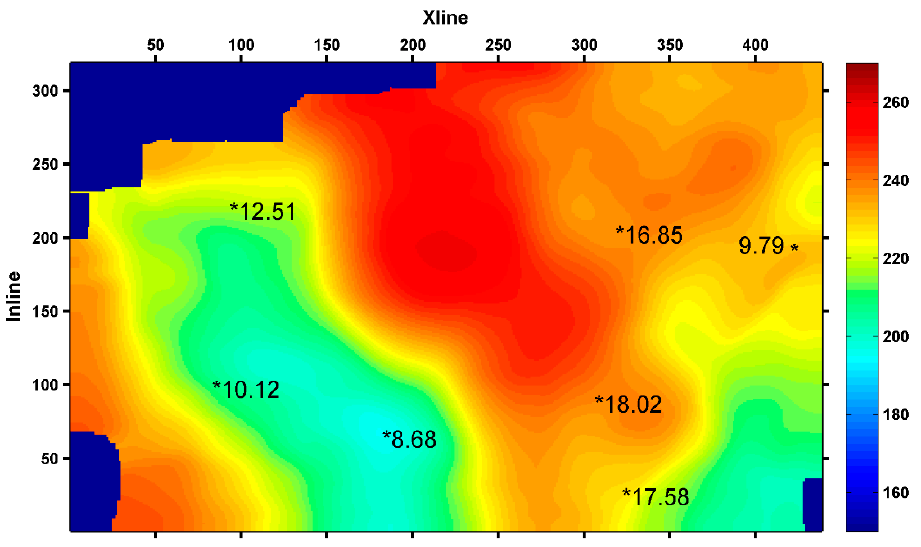
Figure 15. Reconstruction Horizon time of 3# coal seam based on VMDC.